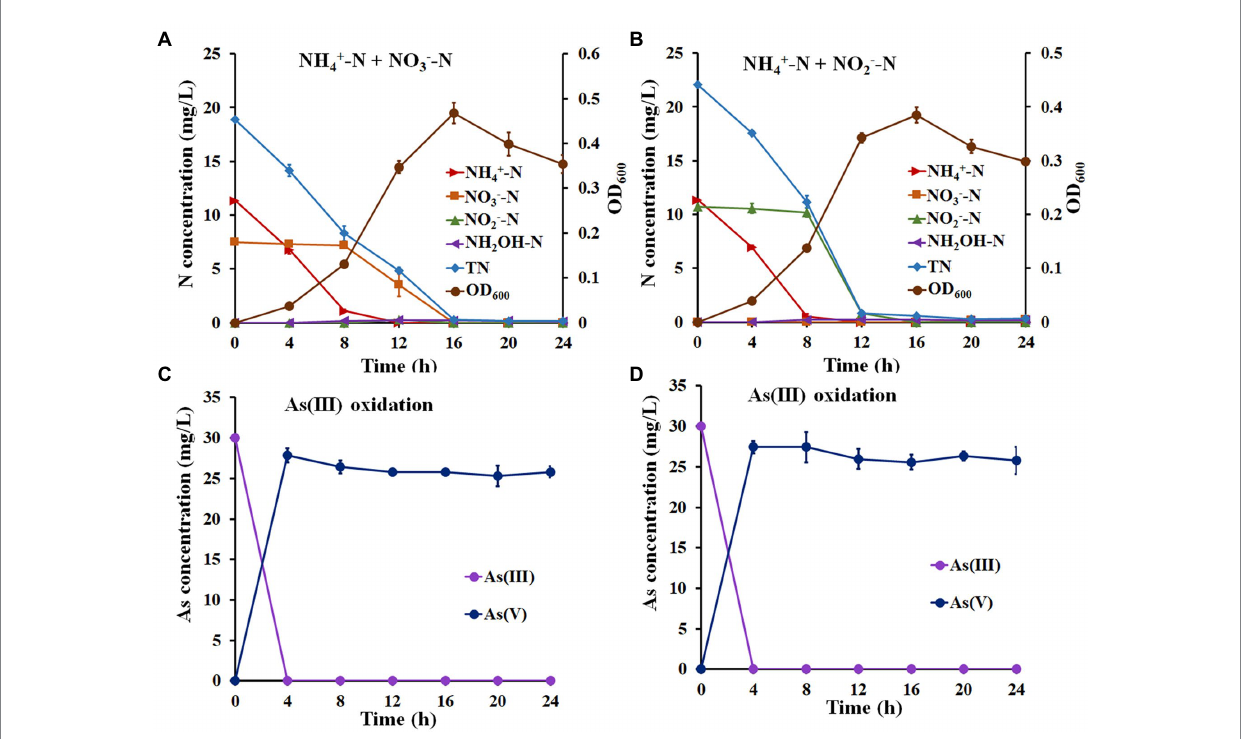
FIGURE 2 Simultaneous nitrification–denitrification and As(III) oxidation of strain H7. Nitrogen removal (A) and As(III) oxidation (C) curves of strain H7 in SND-1 medium containing NH 4+ -N, NO 3 − -N, and As(III). Nitrogen removal (B) and As(III) oxidation (D) curves of strain H7 in SND-2 medium containing NH 4+ -N, NO 2 − -N, and As(III). Error bars represent the mean ± standard deviation ( n =